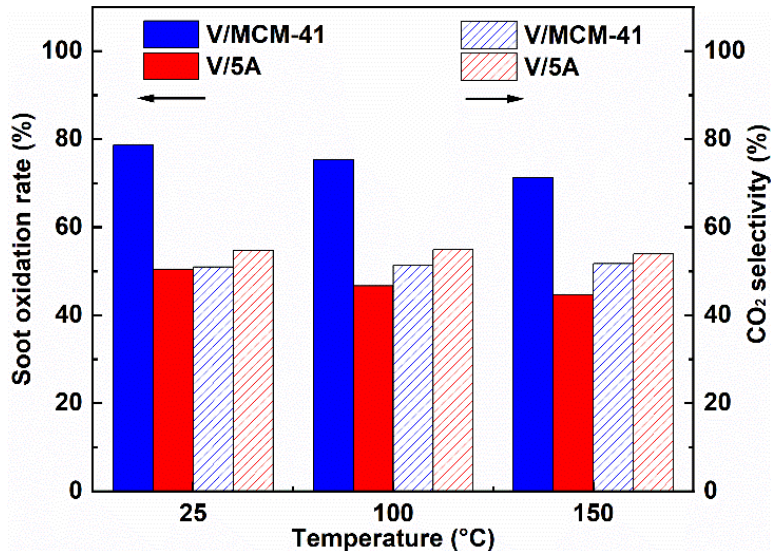
Figure 8. Effect of reaction temperature on soot oxidation rate and CO 2 selectivity of plasma-catalytic soot oxidation at 30th min over V/MCM-41 and V/5A catalysts (Discharge power: 20 W and gas flow rate: 500 mL ∙ min − 1 ).